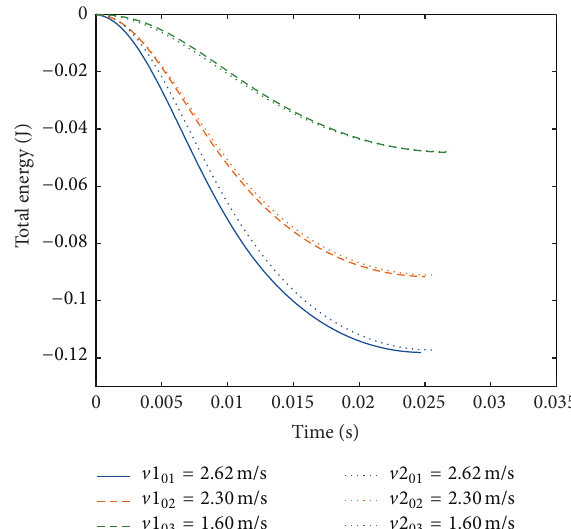
Figure 7: The total mechanical energy dissipated to the granular environment during penetration